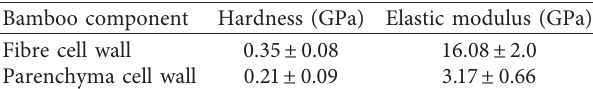
Table 2: Hardness and elastic modulus results of nanoindentation